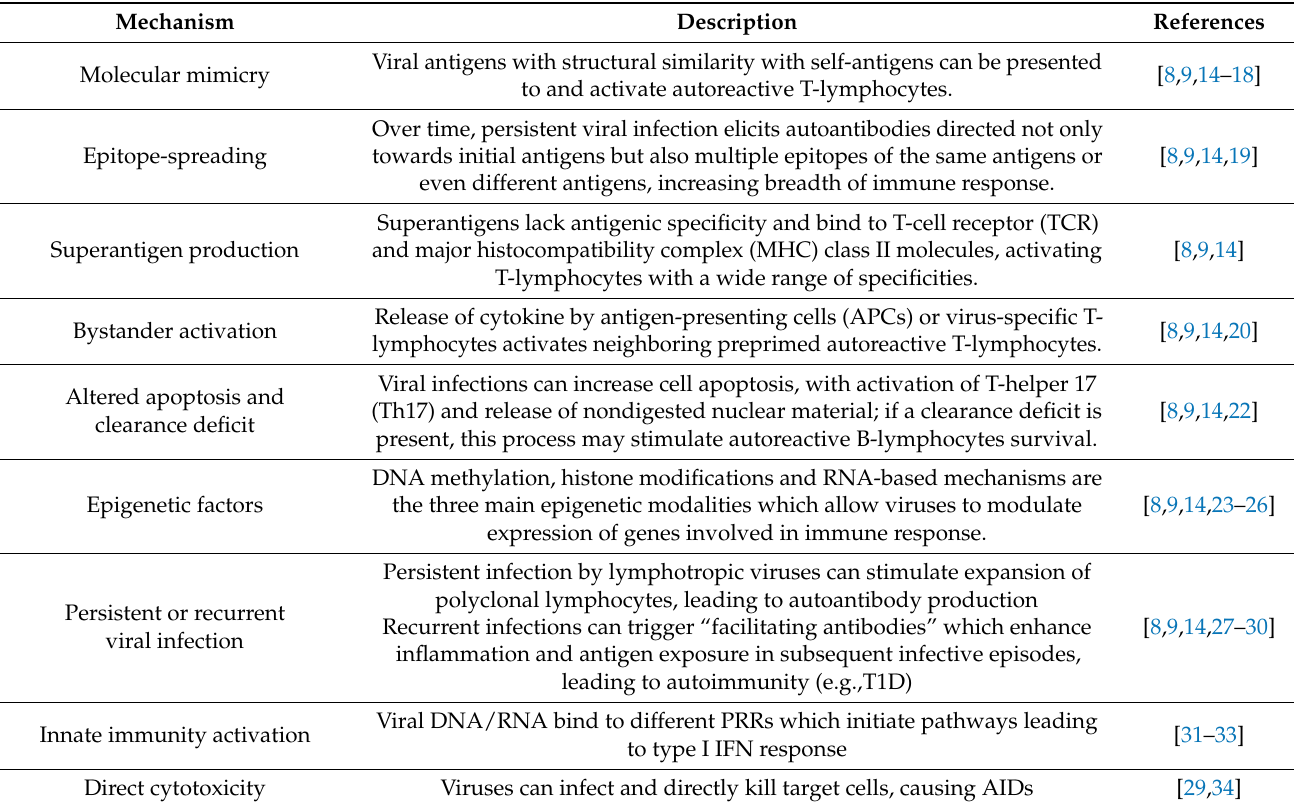
Table 1. General mechanisms of virus-induced